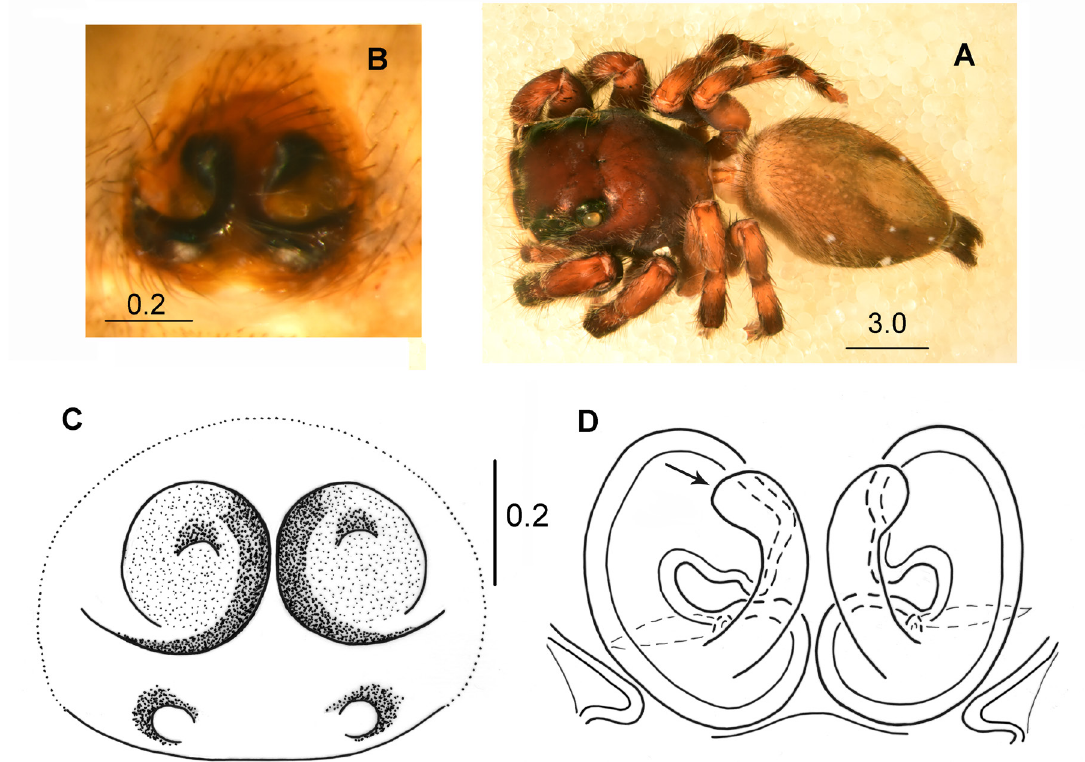
Fig. 21. Hyllus lwoffi Berland & Millot, 1941, ♀ (MNHN). A . Habitus. B–C . Epigyne. D . Internal structure of